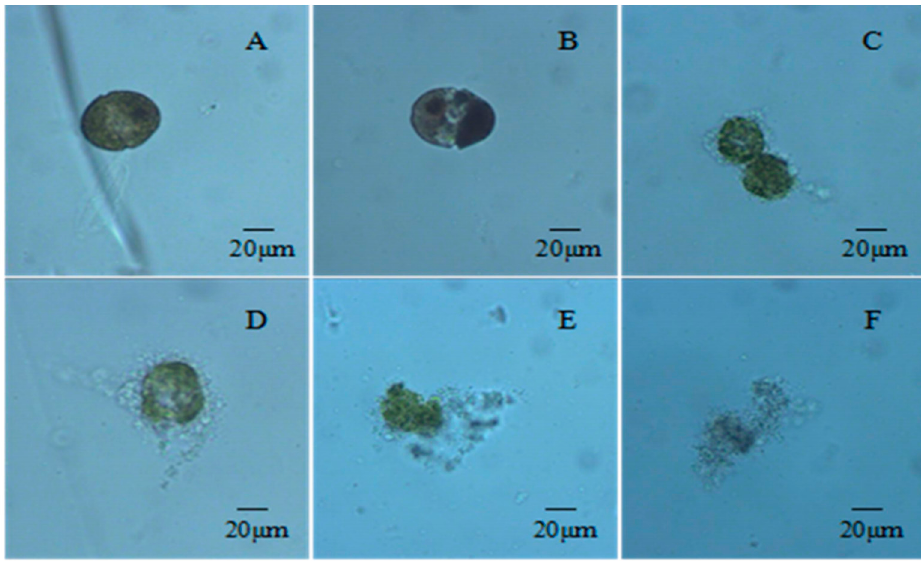
Figure 5. Effect of fermentation broth on G. catenatum (( A )—0 h; ( B )—12 h; ( C )—24 h; ( D )—36 h; ( E ) and ( F )—96 h).